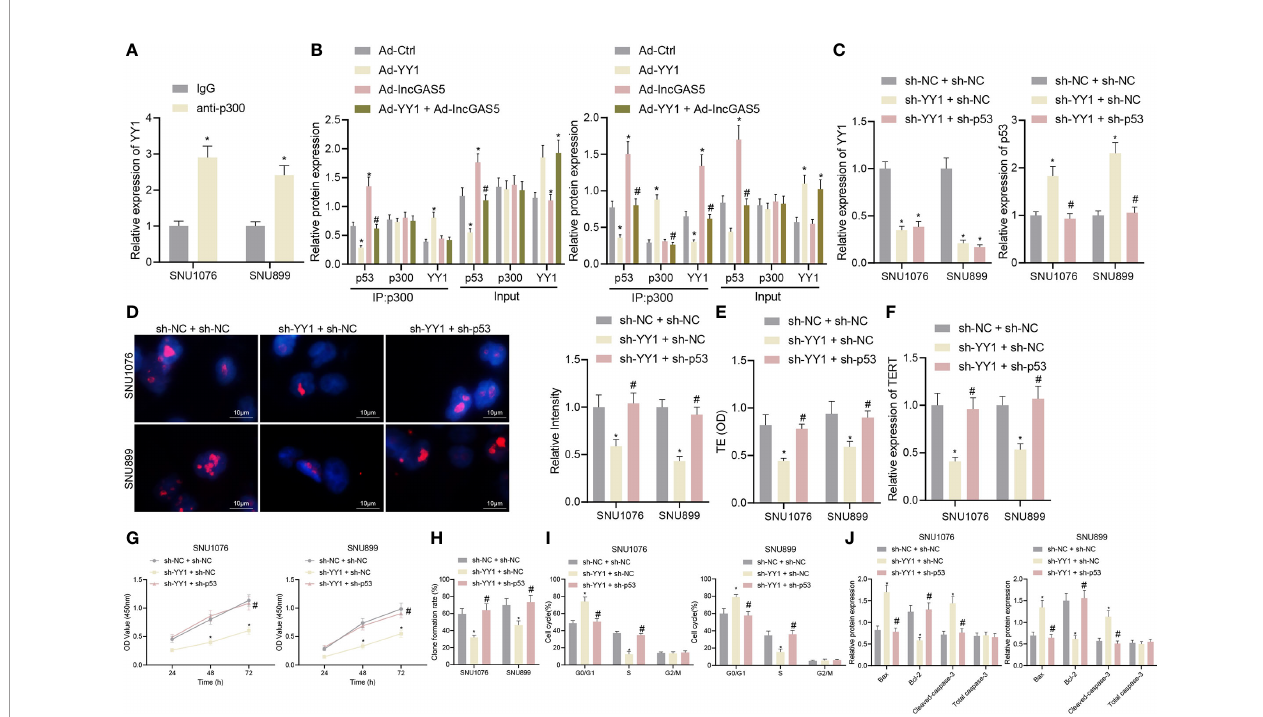
FIGURE 5 | YY1 facilitates telomerase activity and proliferation but inhibits apoptosis of LSCC cells through p53 stability suppression. SNU1076 and SNU899 cells were transfected with sh-YY1 or in combination with sh-p53. (A) ChIP detects the interaction between YY1 and p300, * indicates p < 0.05 compared with IgG. (B) Co-IP detects the interaction between p300 and p53, * indicates p < 0.05 compared with Ad-Ctrl, # indicates p < 0.05 compared with Ad-YY1. (C) The expression of YY1 and p53 stability in cells determined by RT-qPCR. (D) Telomere length of cells measured by Q-FISH (the left). Blue indicates nucleus, and red indicates telomere. (E) Telomerase activity in cells detected by PCR-ELISA. (F) mRNA expression of TERT in cells determined by RT-qPCR. (G) Cell proliferation measured by CCK-8 assay. (H) Colony formation of cells measured by colony formation assay. (I) Cell cycle distribution measured by fl ow cytometry. (J) Western blot analysis of Bax, Bcl-2 and cleaved caspase-3 proteins in cells, normalized to GAPDH, * indicates p < 0.05 compared with sh-NC + sh-NC, # indicates p < 0.05 compared with sh-YY1 + sh-NC. Data are shown as mean ± standard deviation of three technical replicates. Data between two groups were compared by unpaired t -test while those among multiple groups were compared by one-way ANOVA with Tukey ’ s post-hoc tests. Bonferroni-corrected two-way ANOVA was applied for data comparison at various time